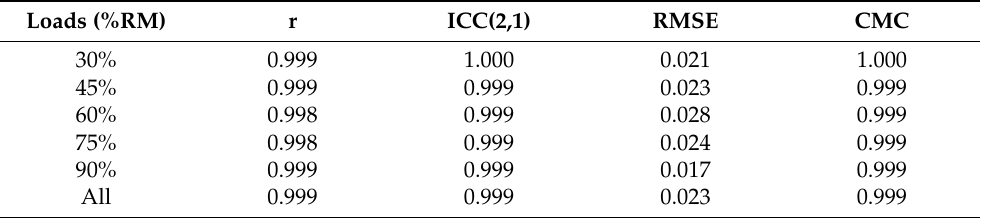
Table 3. Pearson’s correlation coefficient®, ICC, RMSE, and coefficient of multiple correlation (CMC) of full-waveform velocity measured by the FRTMS and the OptiTrack system during different